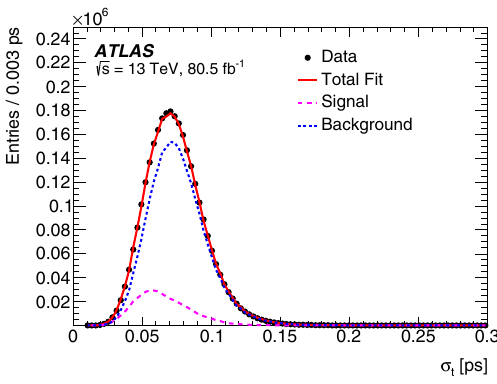
Fig. 6 The proper decay time uncertainty distribution for data (black), and the fits to the background (blue) and the signal (purple) contribu- tions. The total fit is shown as a red curve